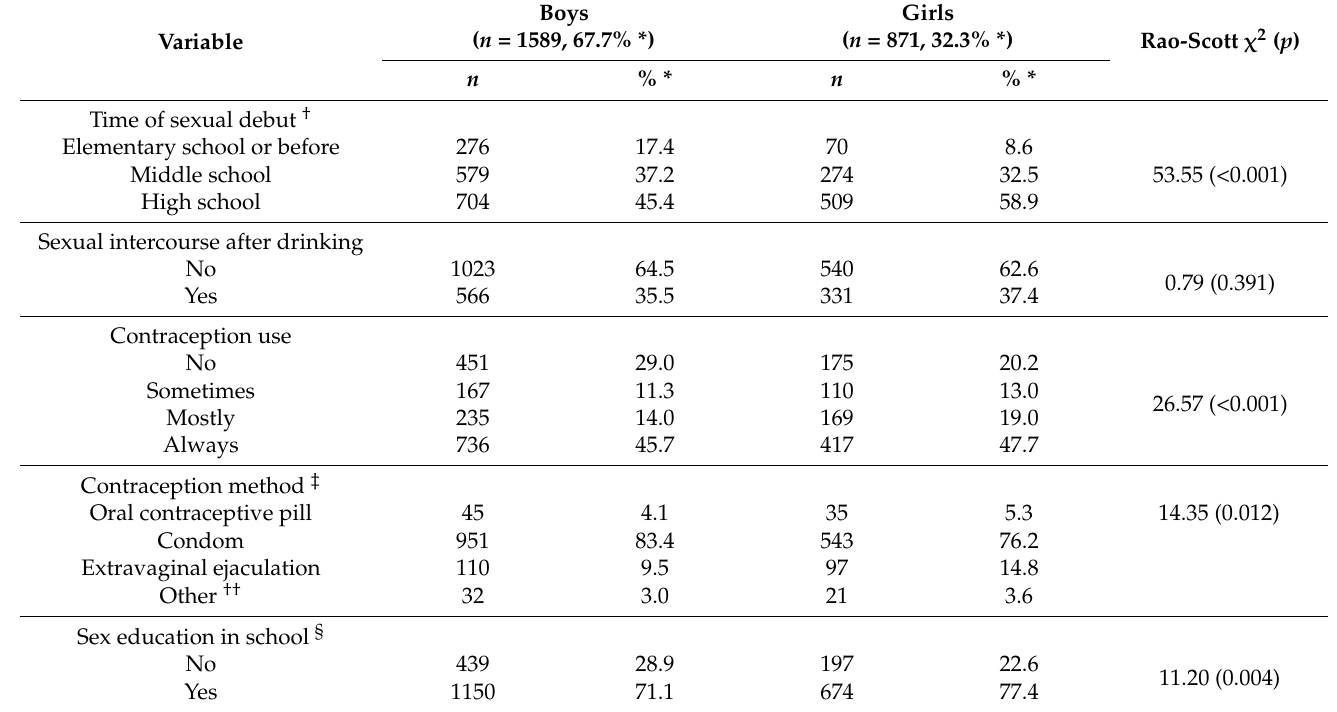
Table 1. Differences in sexual behavior by gender ( n =